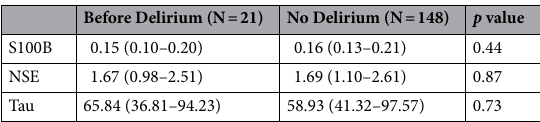
Table 3. Results of biomarkers at admission in patients before delirium and non-delirium patients.